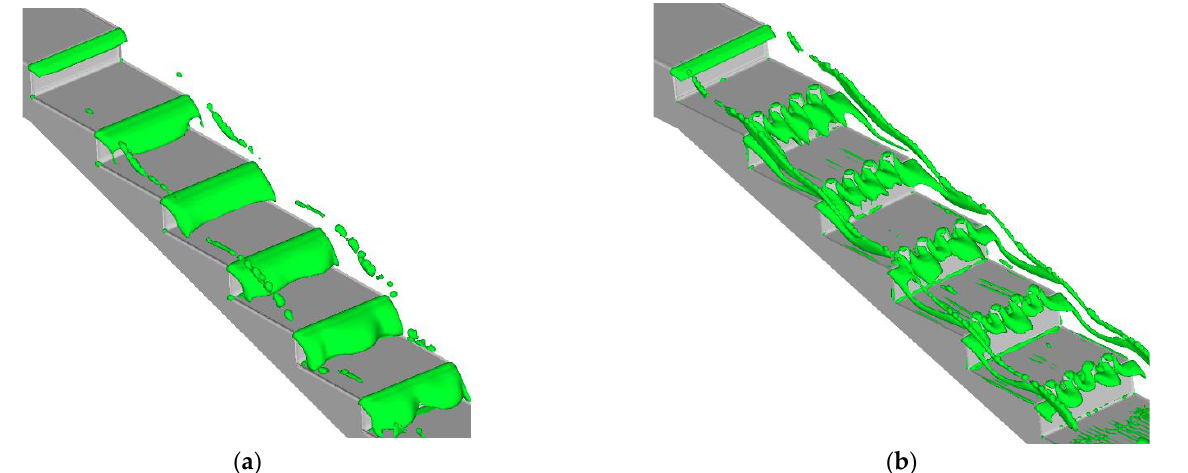
Figure 14. The Q-equivalent surface of two types of step energy dissipators: ( a ) Type I; ( b ) Type II.